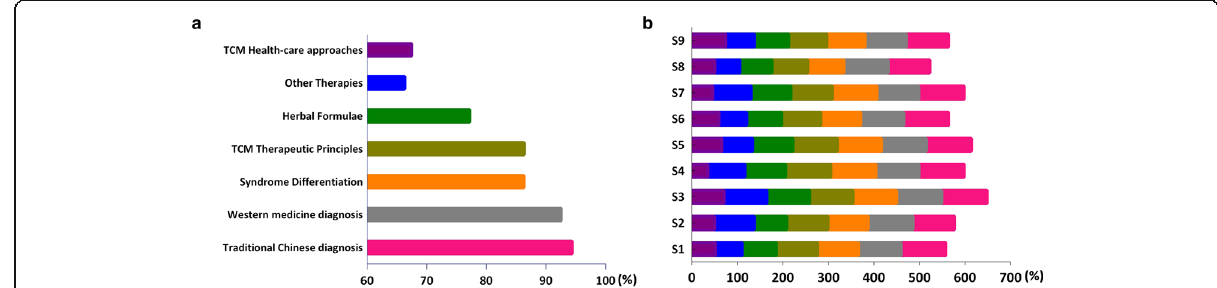
Fig. 5 The Coincidence of clinical practice guidelines for traditional Chinese medicine recommendations and doctor individual interests. a The Coincidence of CPGs recommendations. Seven items include traditional Chinese diagnosis ( pink ), western medicine diagnosis ( grey ), syndrome differentiation ( orange ), CM therapeutic principles ( olive ), herbal formulae ( green ), other therapies ( blue ) and CM health-care approaches ( purple ). Perceived approval rating for each of the key CM diagnosis and treatment recommendations were determined by calculating the percentage of respondents that either agreed or strongly agreed (score 3 and 4). b The Coincidence of CPGs recommendations and nine specialties. S1: Internal medicine; S2: Oncology; S3: Surgery; S4: Gynaecology; S5: Paediatrics; S6: Ophthalmology; S7: Otolaryngology; S8: Anorectal; S9: